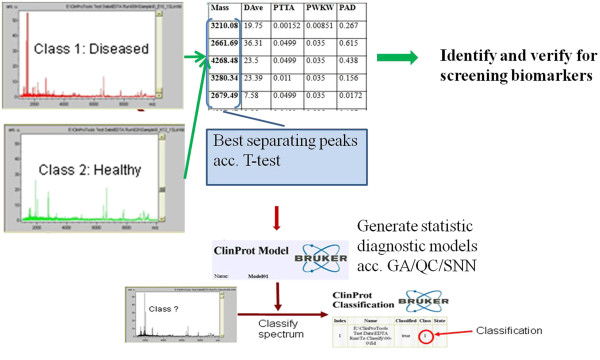
The acquired data of the protein peaks were statistically analyzed.